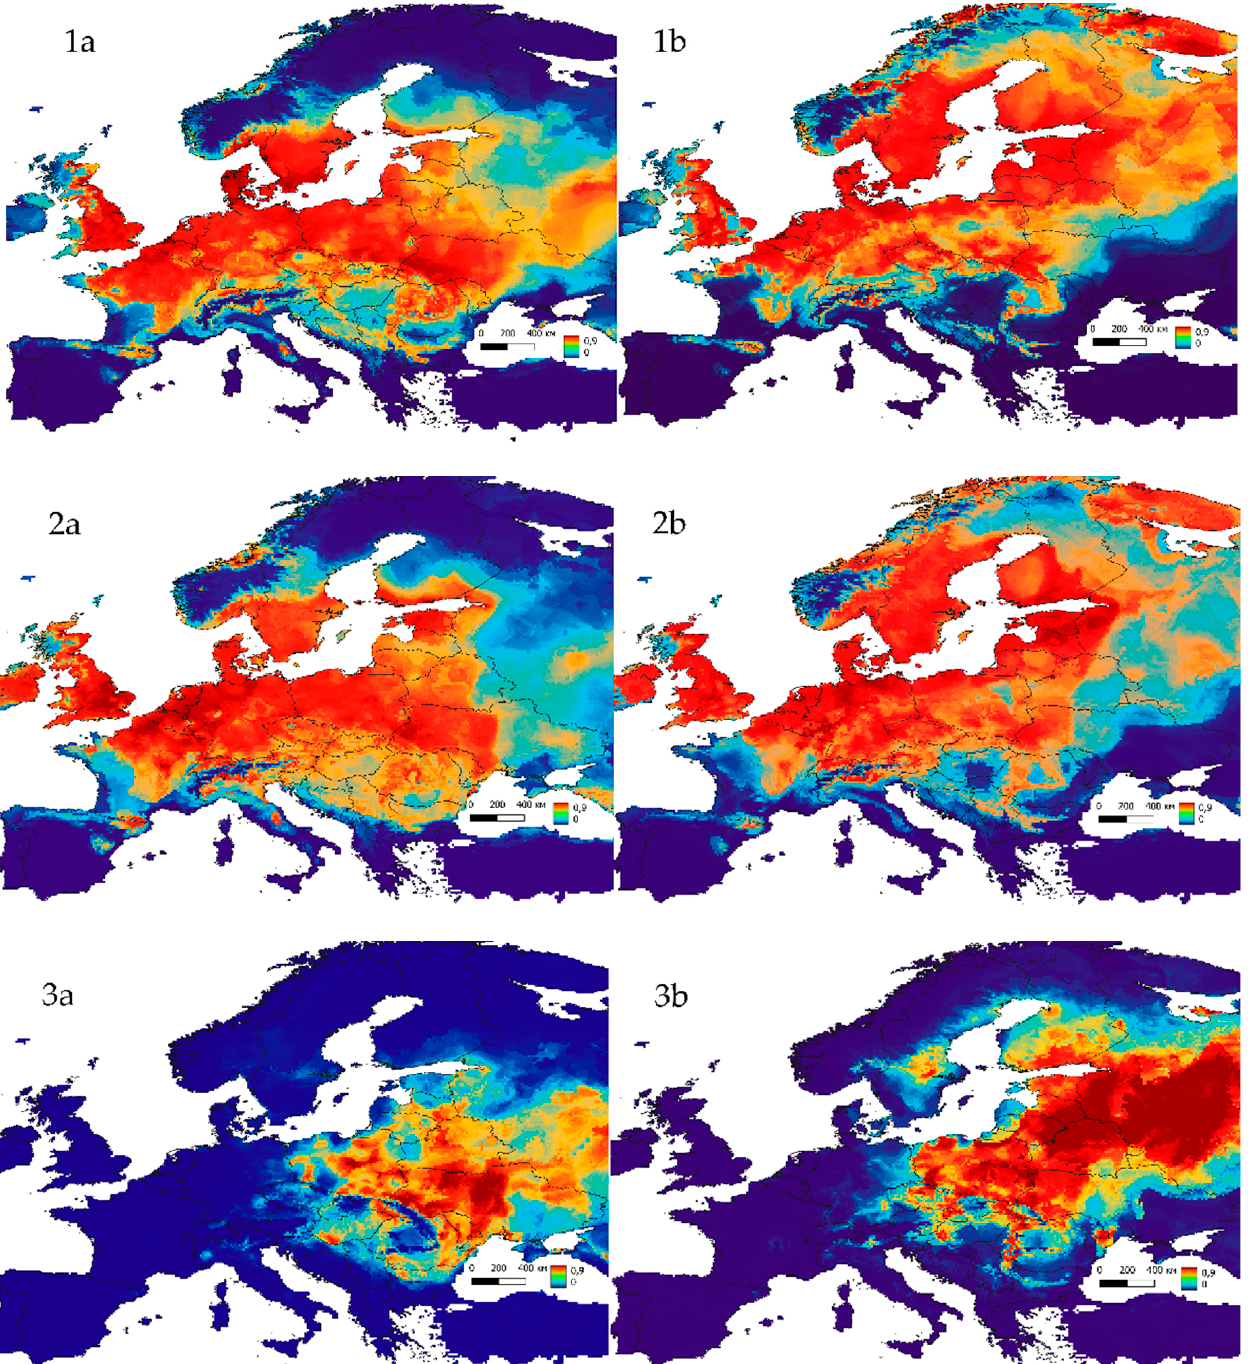
Figure 1. Potential (probabilistic) model: 1— T. cristatus (AUC = 0.85; Bio01 Annual mean tempera- ture: Percent contribution—41.3%, Permutation importance—30.1%); 2— L. vulgaris (AUC = 0.85; Bio01 Annual mean temperature: Percent contribution—30.7%, Permutation importance—12.2%);